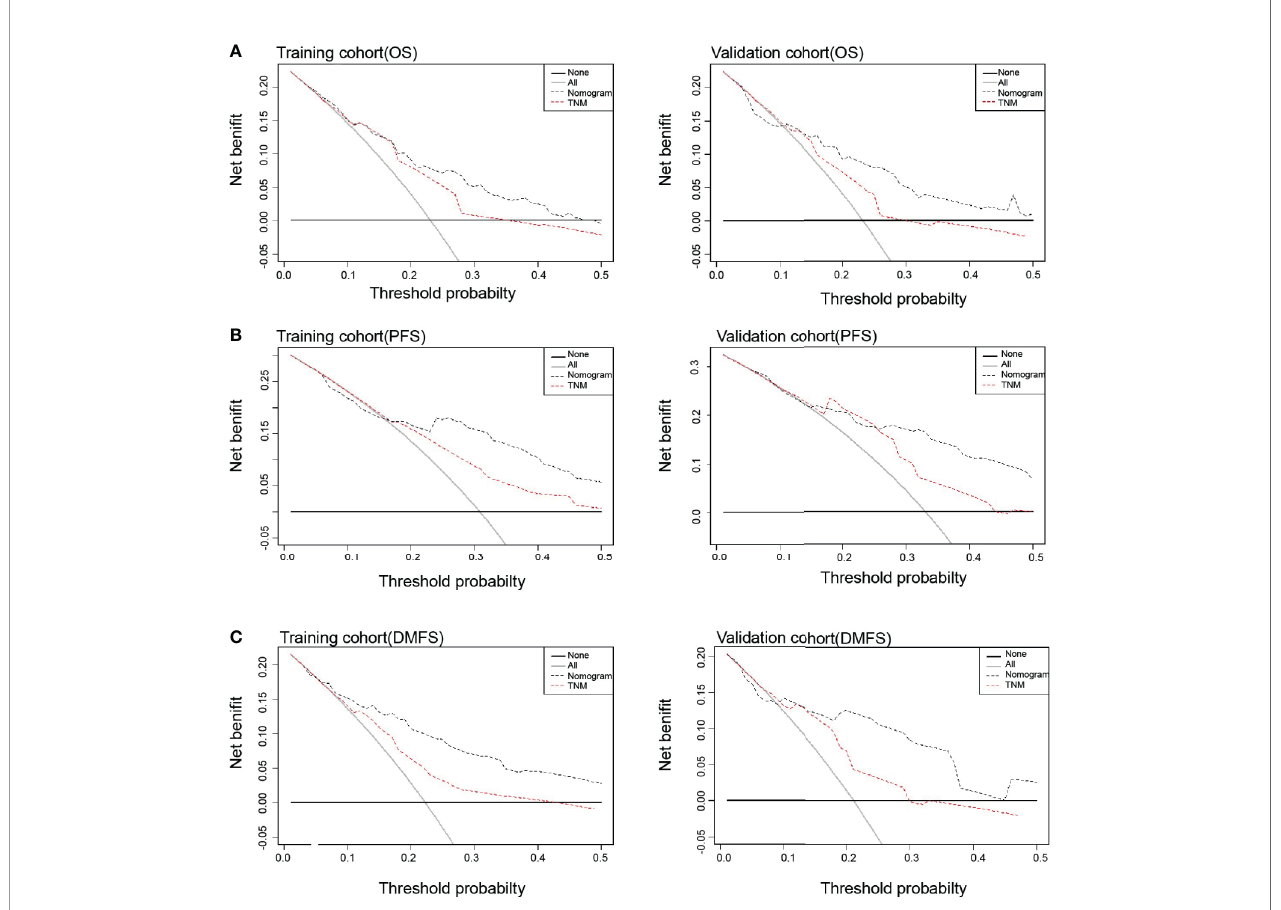
FIGURE 4 | Decision curve analysis of prognostic effects between Nomograms and TNM stage for OS (A) , PFS (B) and DMFS (C) in both training and validation